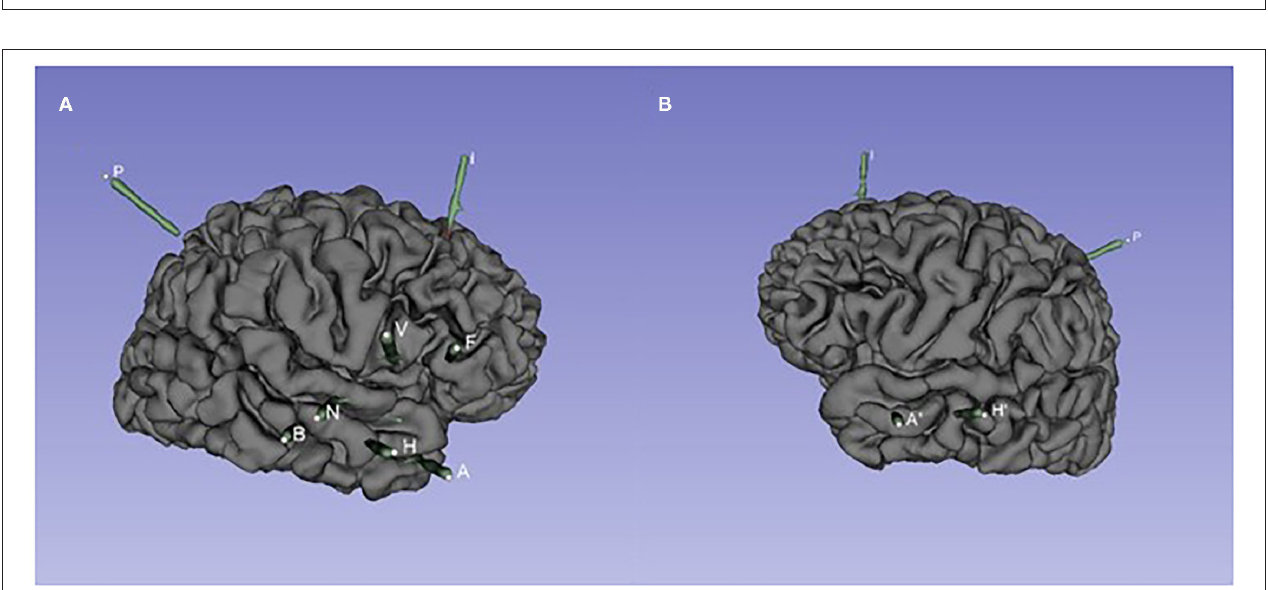
FIGURE 1 | (A) T1-weighted MRI and PET results of case 1. No abnormality was found in MRI, while hypometabolism was identified in the right superior temporal gyrus. (B) Stereoelectroencephalography (SEEG) signals in the ictal period. Fast activities originated from the right superior temporal gyrus ‹ (N1-8) and spread rapidly to the right insular lobe › (I3-8) and hippocampus fi (H1-3, B1-3). White arrow: the location of the electrodes N in MRI (right superior temporal gyrus).